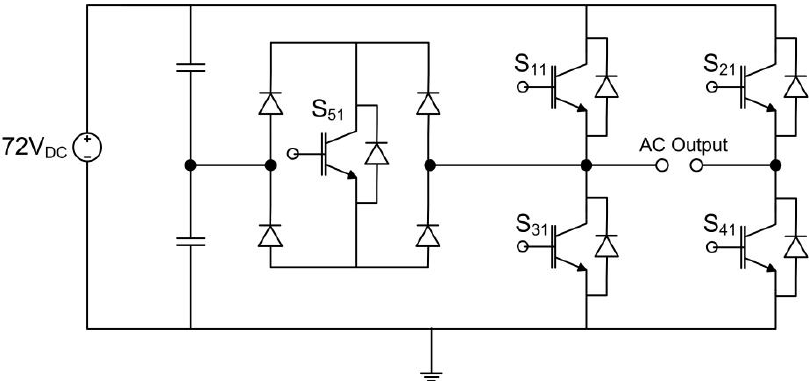
Table 1. Active power switches for a 21-level multilevel inverter for SHE modulation